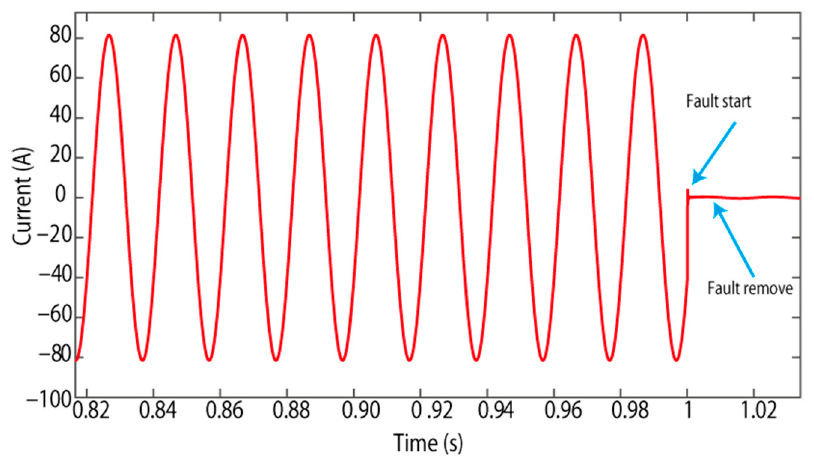
Figure 9. Current at load point 3 during cyber-attacks CB failure.